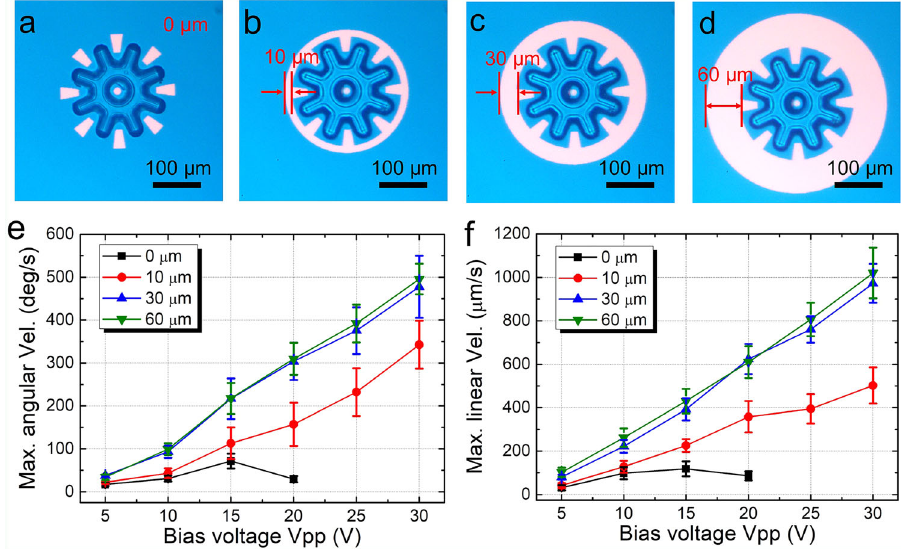
Fig. 2 Effect of optical ring-spanner geometry on micromotors. Microscope images of micro-gears controlled by optical ring spanners with ring thicknesses of a 0 μ m, b 10 μ m, c 30 μ m, and d 60 μ m. Plots of maximum e angular velocity of rotating micro-gears and f linear velocity of translating micro-gears as a function of OET bias voltage for optical ring spanners with ring thicknesses of 0 μ m (black squares), 10 μ m (red circles), 30 μ m (blue triangles), and 60 μ m (green inverted triangles). The frequency of the OET bias was set to 10 kHz. Error bars represent ±1 SD from fi ve measurements for each